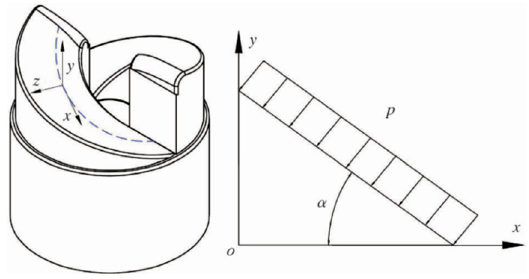
Figure 17. Schematic of the composite impactor. 1—upper sub; 2—nozzle; 3—shell; 4—load trans-